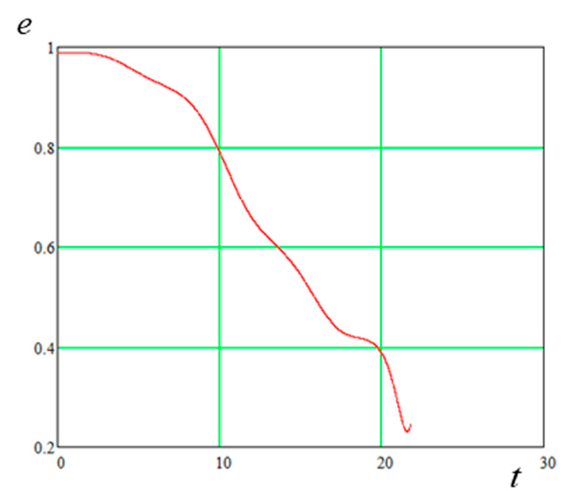
Figure 7. Dependence of the apogee radius [undim.] of the osculating SC orbit as a function of flight time [undim.].